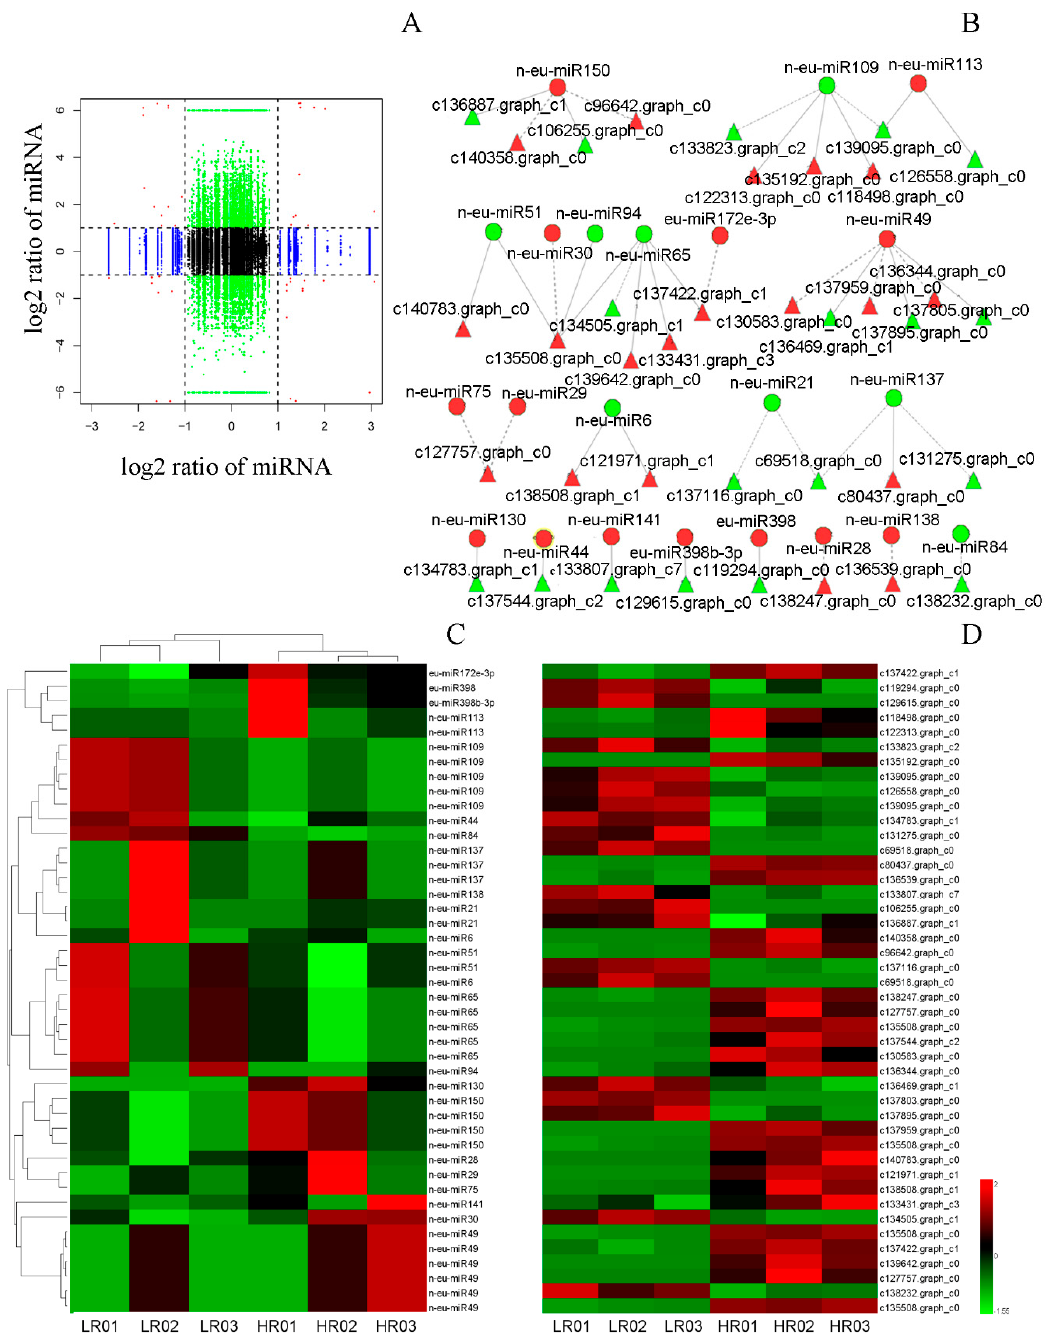
Figure 7. A combined view of the genome-wide expression profiles and the regulatory relationship between miRNAs and their targets in E. ulmoides . ( A ) Overview of genome-wide expression profiles between miRNA and their targets. The x-axis represents the miRNAs expression levels (log 2 (fold-change)), and the y-axis represents the target genes expression levels (log 2 (fold-change)); ( B ) the interaction network between differentially expressed miRNAs (DEMs) and their differentially expressed targets in E. ulmoides . Red circles indicate up-regulated miRNAs, green circles indicate down-regulated miRNAs, and red triangles indicate up-regulated targets, green triangles indicate down-regulated targets; ( C , D ) the combined view of expressions levels between DEMs and their differentially expressed targets, respectively. Both the original expression values of miRNAs and targets were normalized using Z-score normalization.